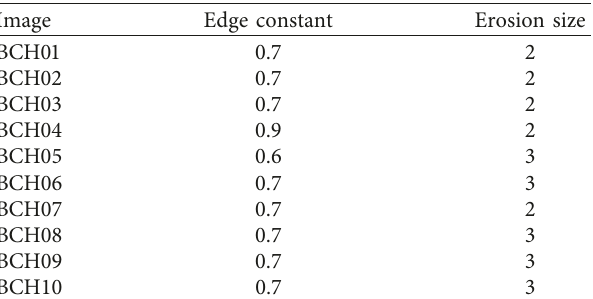
Figure 1: Original FLAIR image, image after applying bias field correction, and image after applying skull stripping. Table 1: Parameters used in the